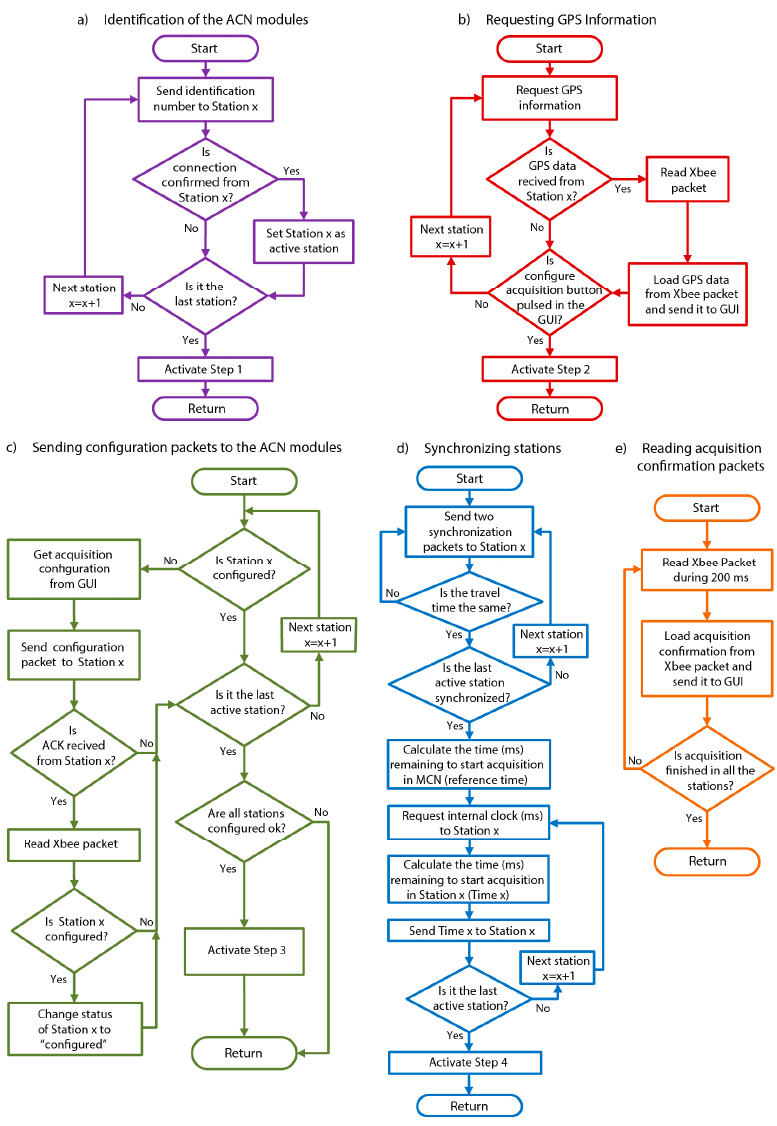
Figure 8. Detailed flowchart of the MCN